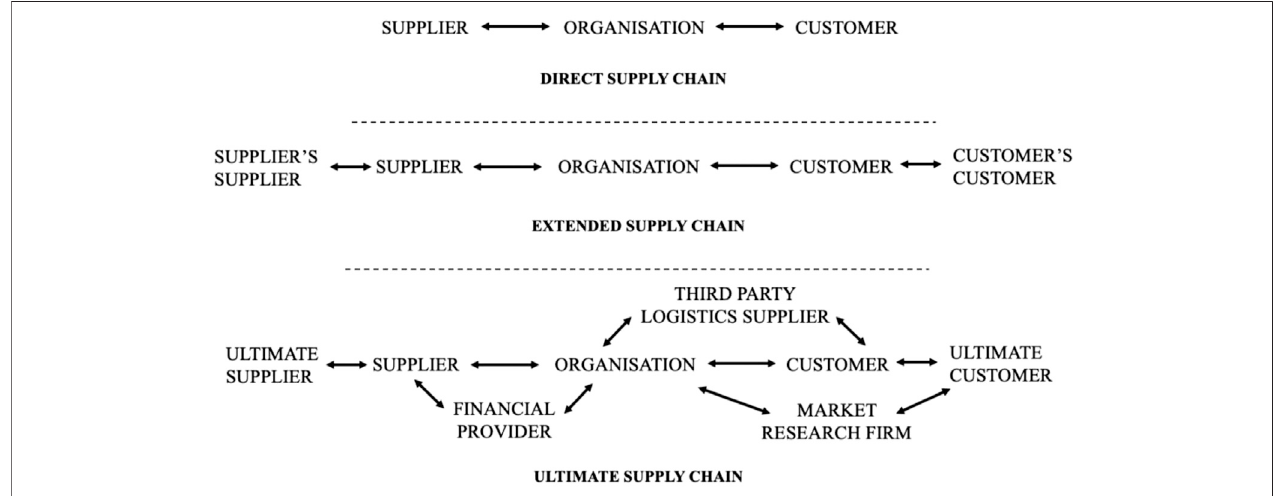
FIGURE 1 | Types of supply chain complexity